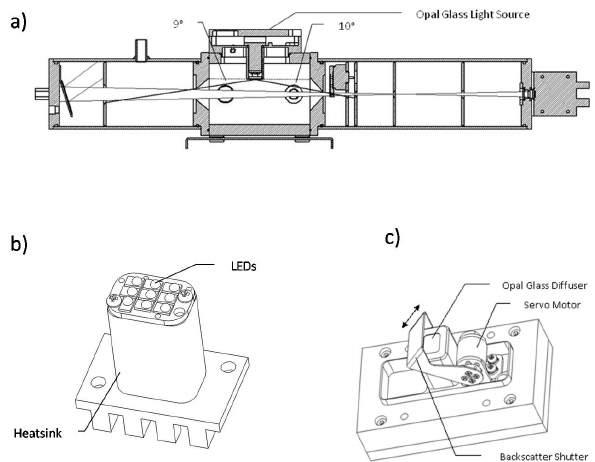
Fig. 1. Sketch of the Aurora 3000. (a) Sensing volume and indi- cated truncation angles, (b) arrangement of LEDs, (c) light source with motor driven backscatter